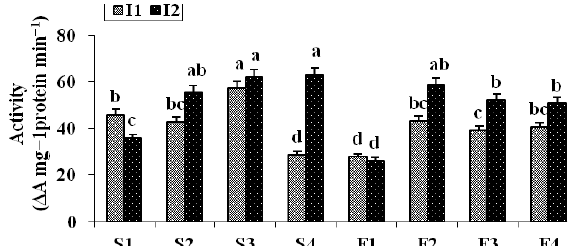
Fig. 4. Changes in peroxidase activity due to water deficit stress and application of Fe; I1- normal irrigation or irrigation to reach 50% soil moisture depletion of field capacity, I2- irrigation from the beginning of flowering to the end of pollination stage reaching 75% of soil moisture depletion of field capacity; S- soil application of Fe, S1- without soil application of Fe; S2- 50 Fe Kg ha -1 , S3- 100 Fe Kg ha -1 , S4- 150 Fe Kg ha -1 ; F- foliar application of Fe, F1- foliar application of water, F2- 1,000 Fe mg l -1 , F3- 2,000 Fe mg l -1 , F4- 3,000 Fe mg l -1 ; LS MEANS within each column of each section followed by the same letter are not significantly different (p≤0.05)